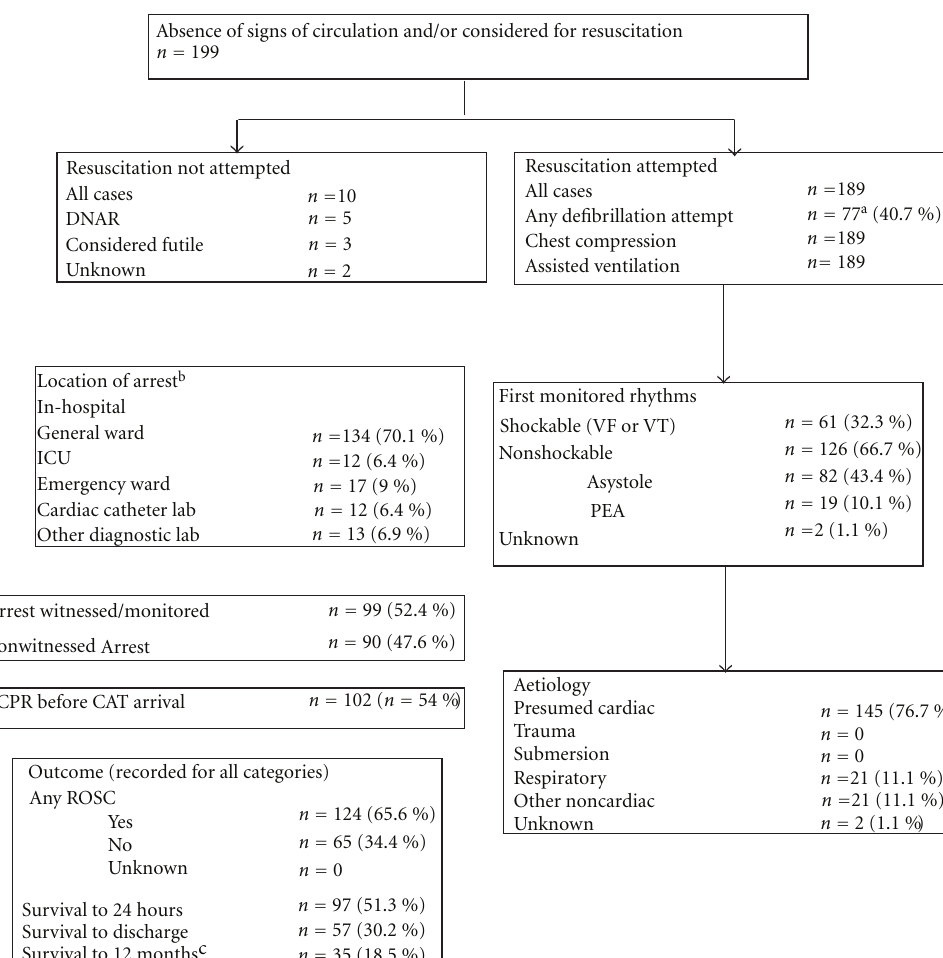
Figure 1: Utstein style chart for the core data. a missing data on defibrillation attempts in one patient; b missing data on the location of arrest in one patient; c missing data on the vital status after 12 months in 7